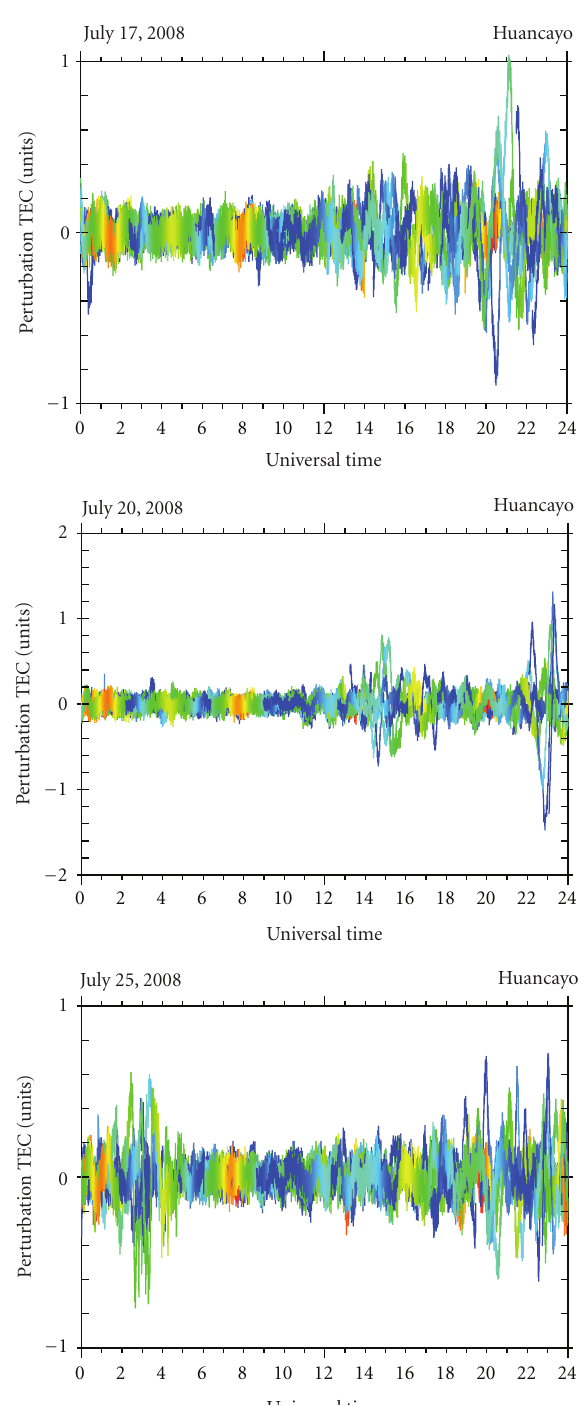
Figure 3: TECP versus UT at Huancayo for three days in July. Data from various GPS satellite signals are plotted; each satellite is distinguished by a di ff erent